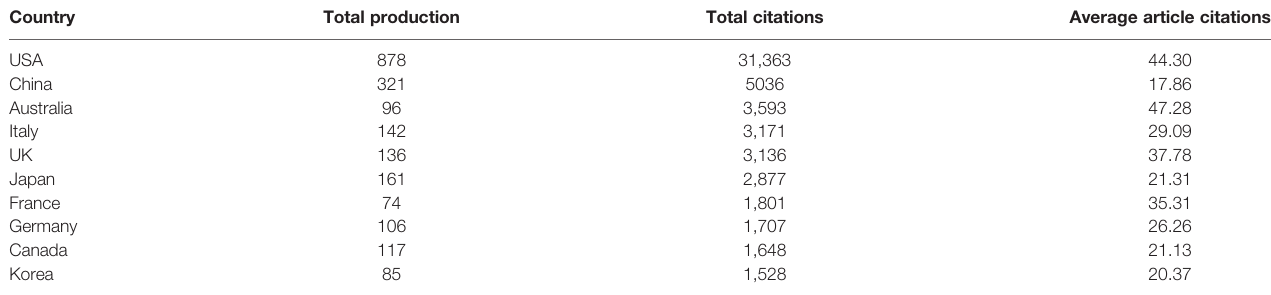
TABLE 1 | Top 10 cited countries contributing to this research area.